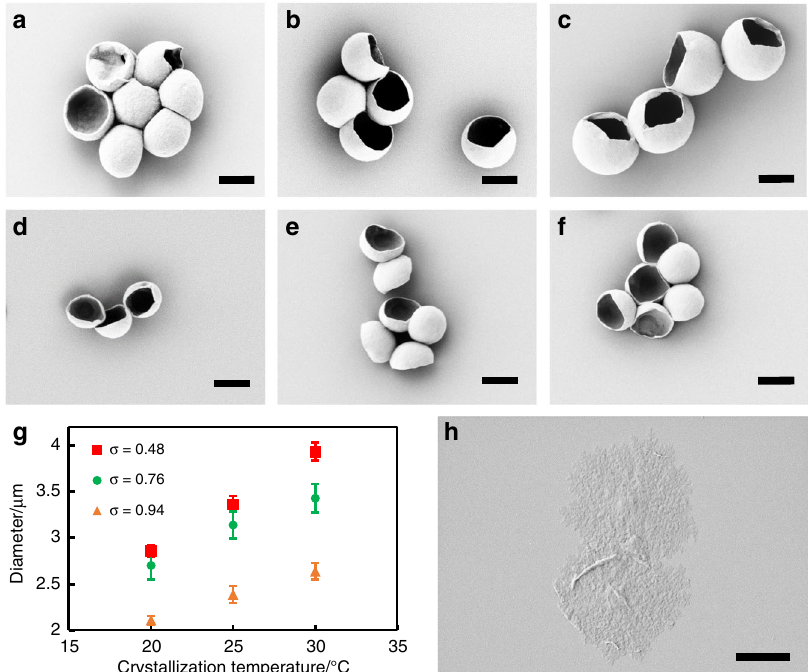
Fig. 4 Manipulating PEO mBBC sizes via grafting density. ( a – f ) SEM images of mBBCs of mBB 707 -PEO 114 -48 ( a – c ) and mBB 707 -PEO 114 -94 ( d – f ), T c = 20 ( a , d ), 25 ( b , e ) and 30 °C ( c , f ). ( g ) Plot of mBBC diameter vs. T c ; error bar represents standard deviation based on measurements of ten mBBCs. ( h ) SEM image of mBB 707 -PEO 114 -10 crystal. Scale bars: 2 μ